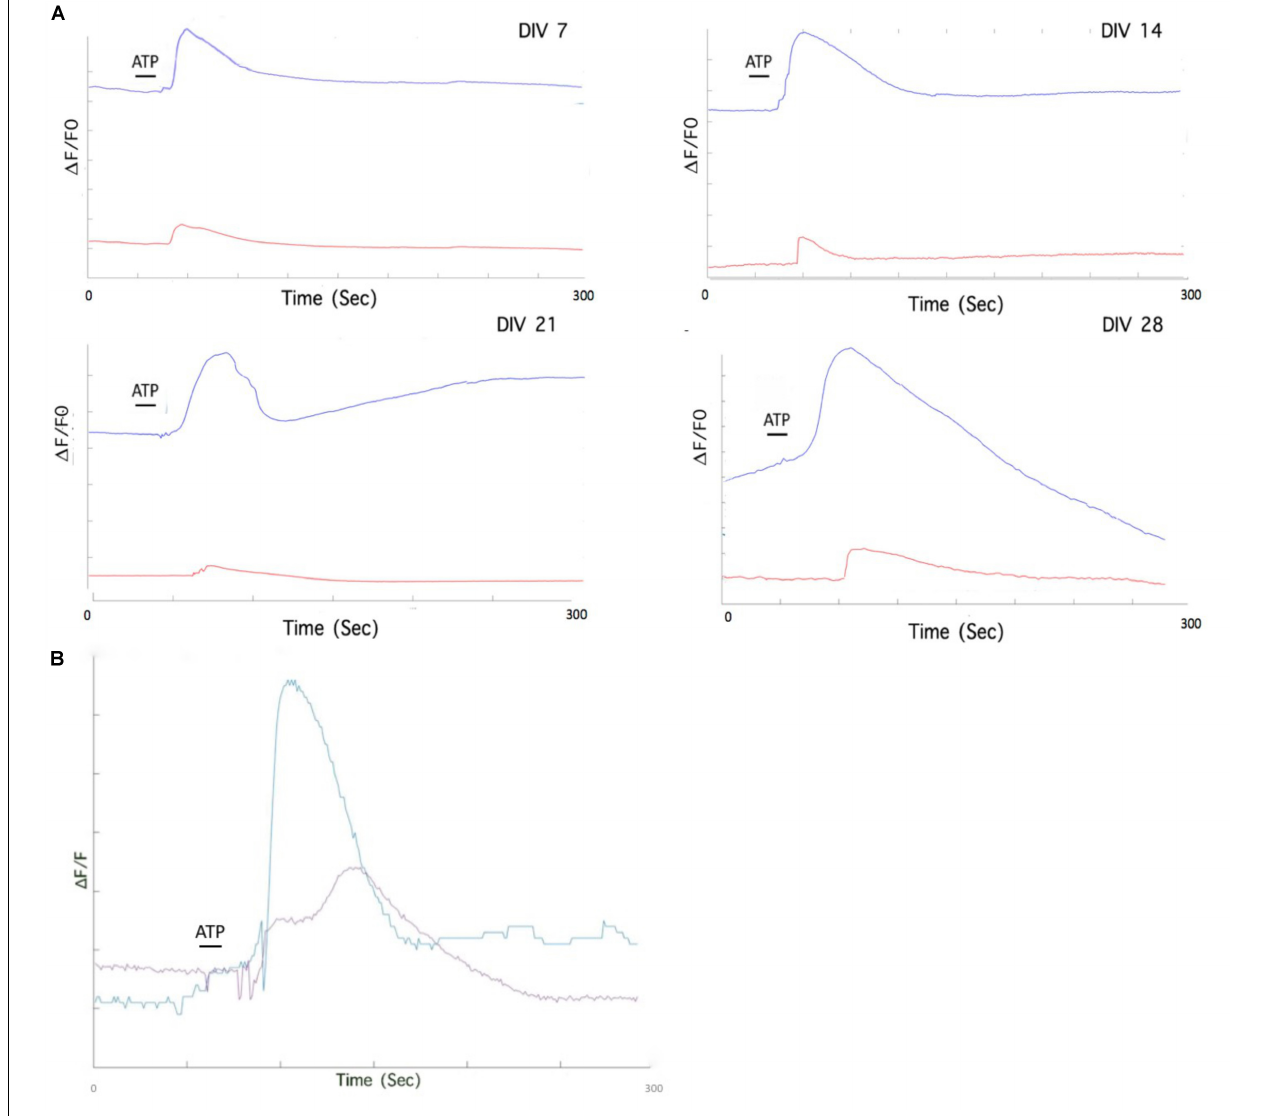
FIGURE 8 | Pharmacological treatment of mESC derived astrocytes isolates individual purinoceptor contributions to Ca 2 + elevation. (A) Individual astrocytes from MRS2179 treated DIV 7-DIV 28 cultures exhibit stunted Ca 2 + responses after ATP application (red traces), compared to untreated astrocytes (blue traces). (B) Pharmacological treatment of mESC derived astrocytes with phospholipase C (PLC) inhibitor, U73122. Bath incubation of DIV 28 astrocytes with U73122 results in a stunted response upon ATP stimulation. Purple trace. ATP response after U73122 treatment; Blue trace, ATP response without U73122